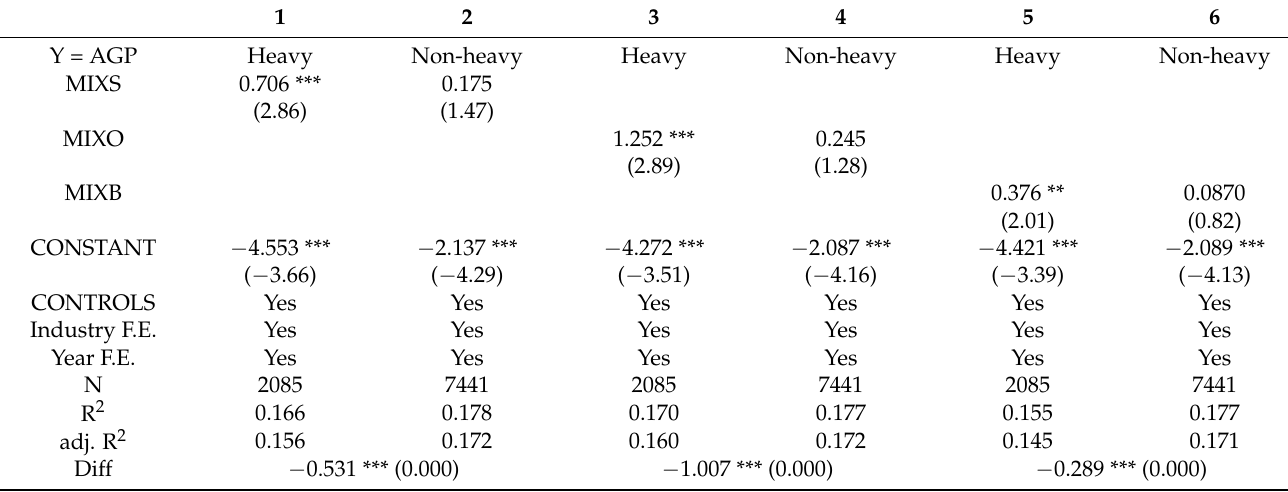
Table 11. The relationship between mixed-ownership reform and green innovation of SOEs under different industry